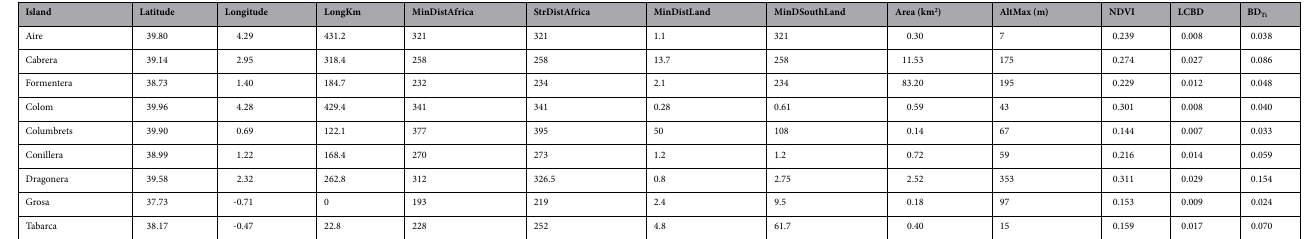
Table 3. Values of the island descriptors (see Table 2) and two measures of temporal variability of migrant composition in each island: average local contribution of each island to beta diversity (LCBD) and beta diversity for each island (BD Ti